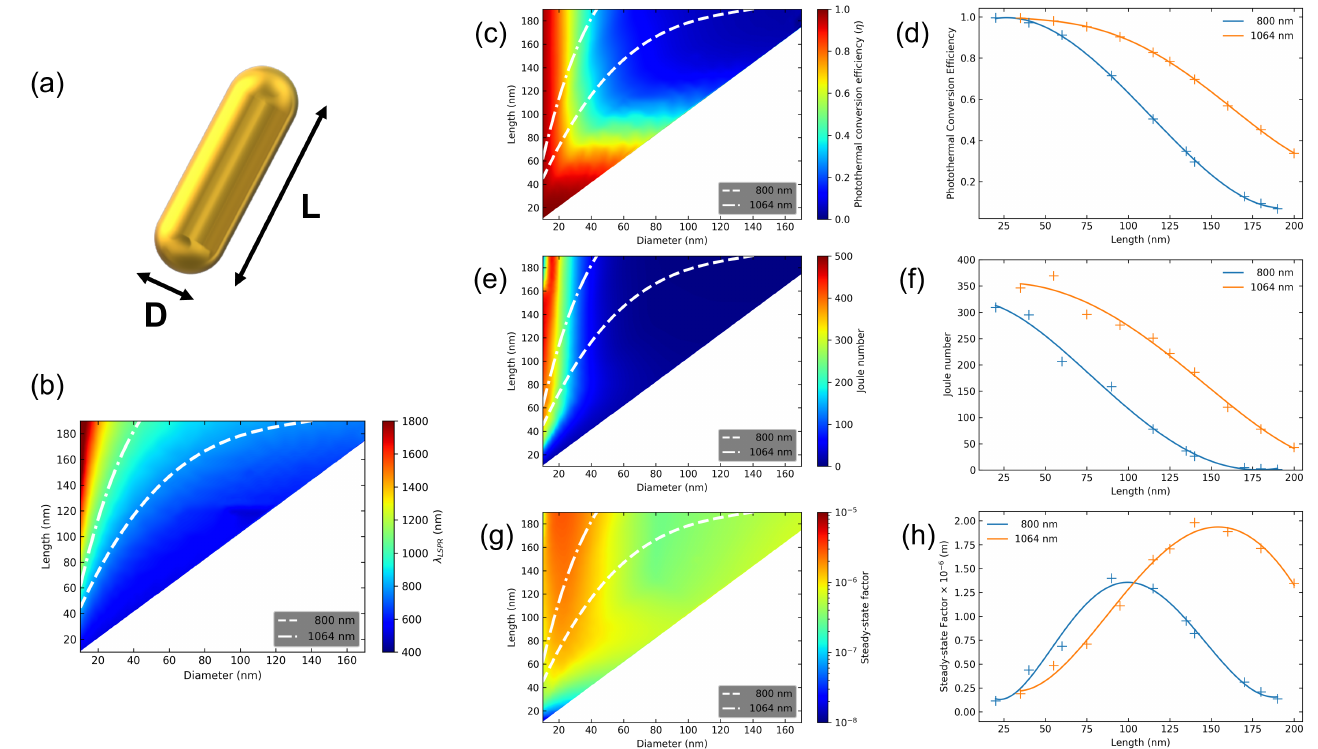
Figure 2. ( a ) Scheme of an AuNR and its dimensions. ( b ) LSPR colormap as a function of AuNR length and diameter. ( c , e , g ) Colormaps for η , Jo and S 2 F , respectively, for various AuNR dimensions. The outlined dashed and dash-dotted curves in all colormaps depict AuNR dimensions in which the plasmon peak occurs for 800 nm and 1064 nm, respectively. ( d , f , h ) Evolution of η , Jo and S 2 F as a function of AuNR size. The blue curves represents AuNR sizes with LSPR in 800 nm, while the orange curves portrays AuNR sizes with LSPR in 1064